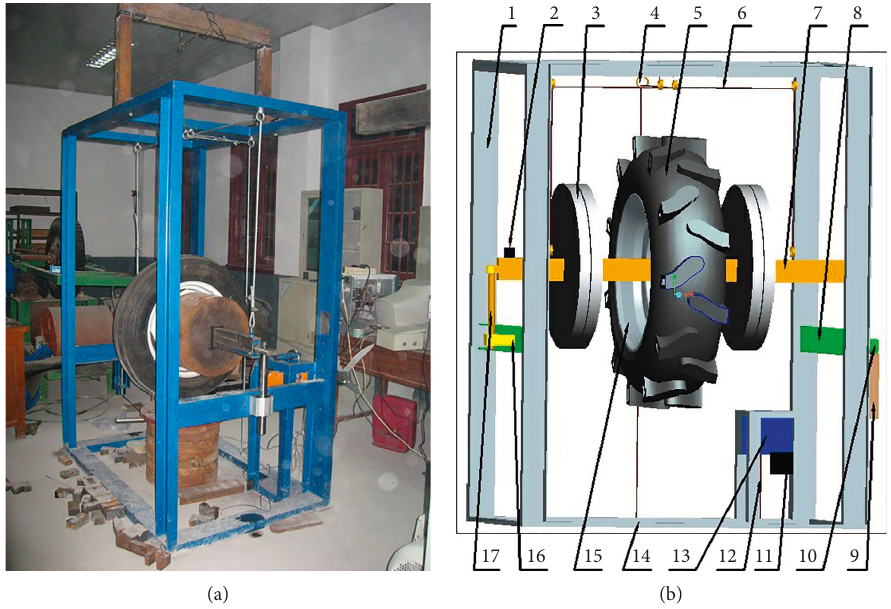
Figure 6: Test device of stiffness and damping for tire: (a) site map; (b) structure principle.